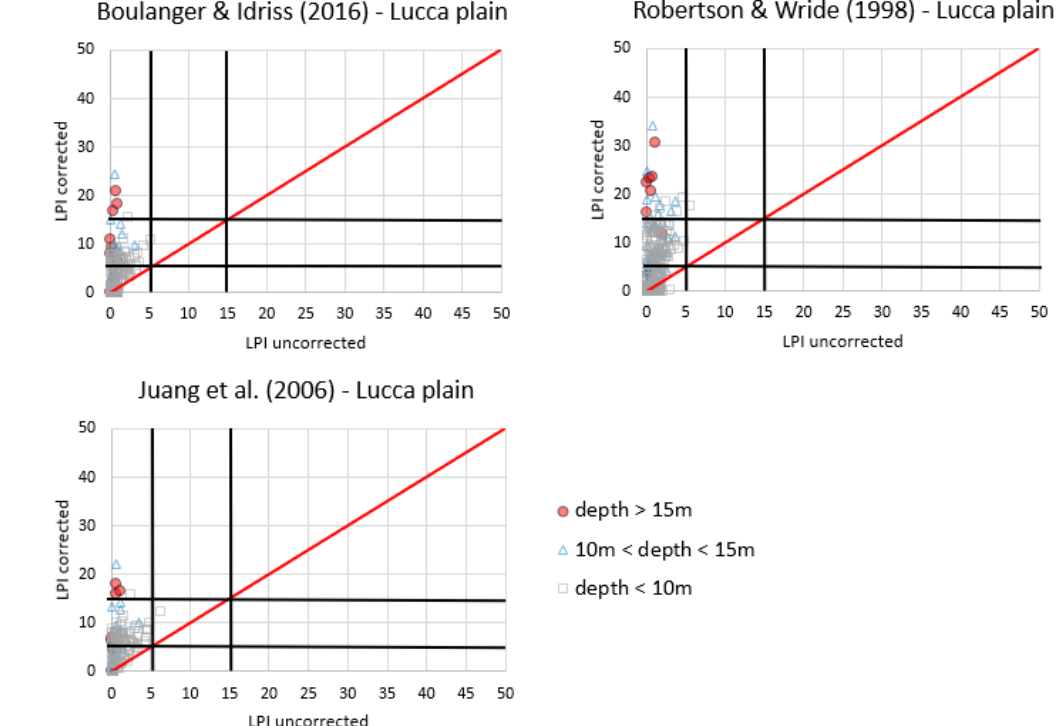
/ o corrections) for the macro-area of the Lucca plain. Geosciences 2020 , 10 , x FOR PEER